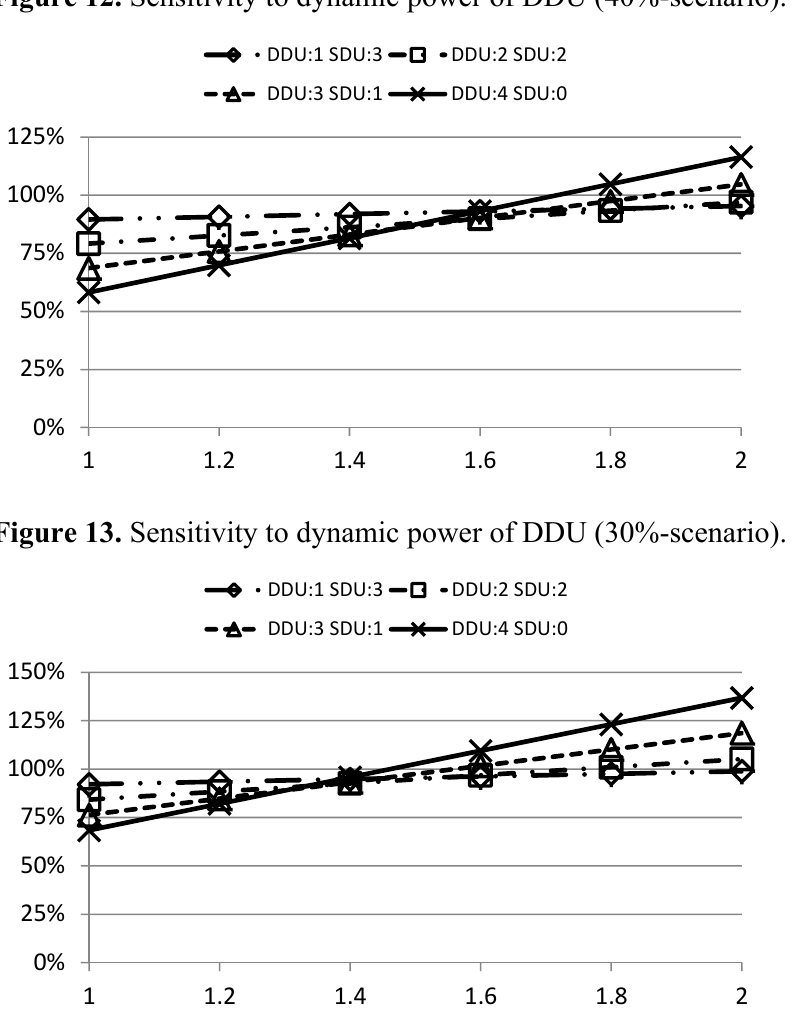
Figure 12. Sensitivity to dynamic power of DDU (40%-scenario).